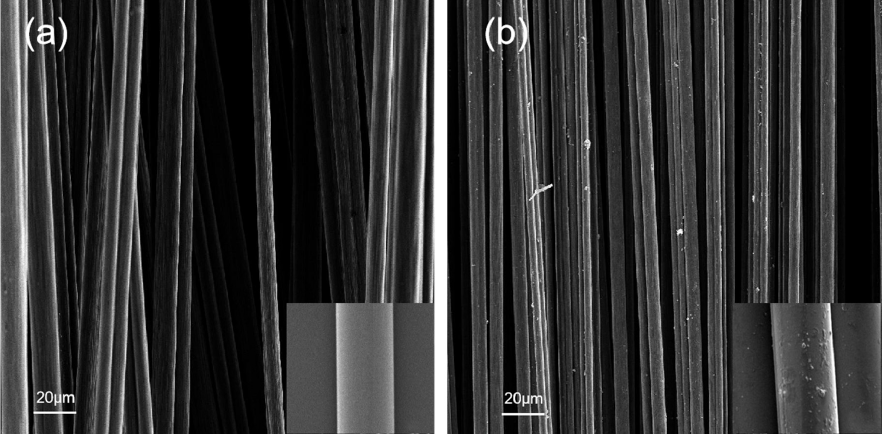
Figure 5. Microscopic morphology of the glass fibre surface ( a ) glass fibre before modification ( b ) glass fibre after modification.